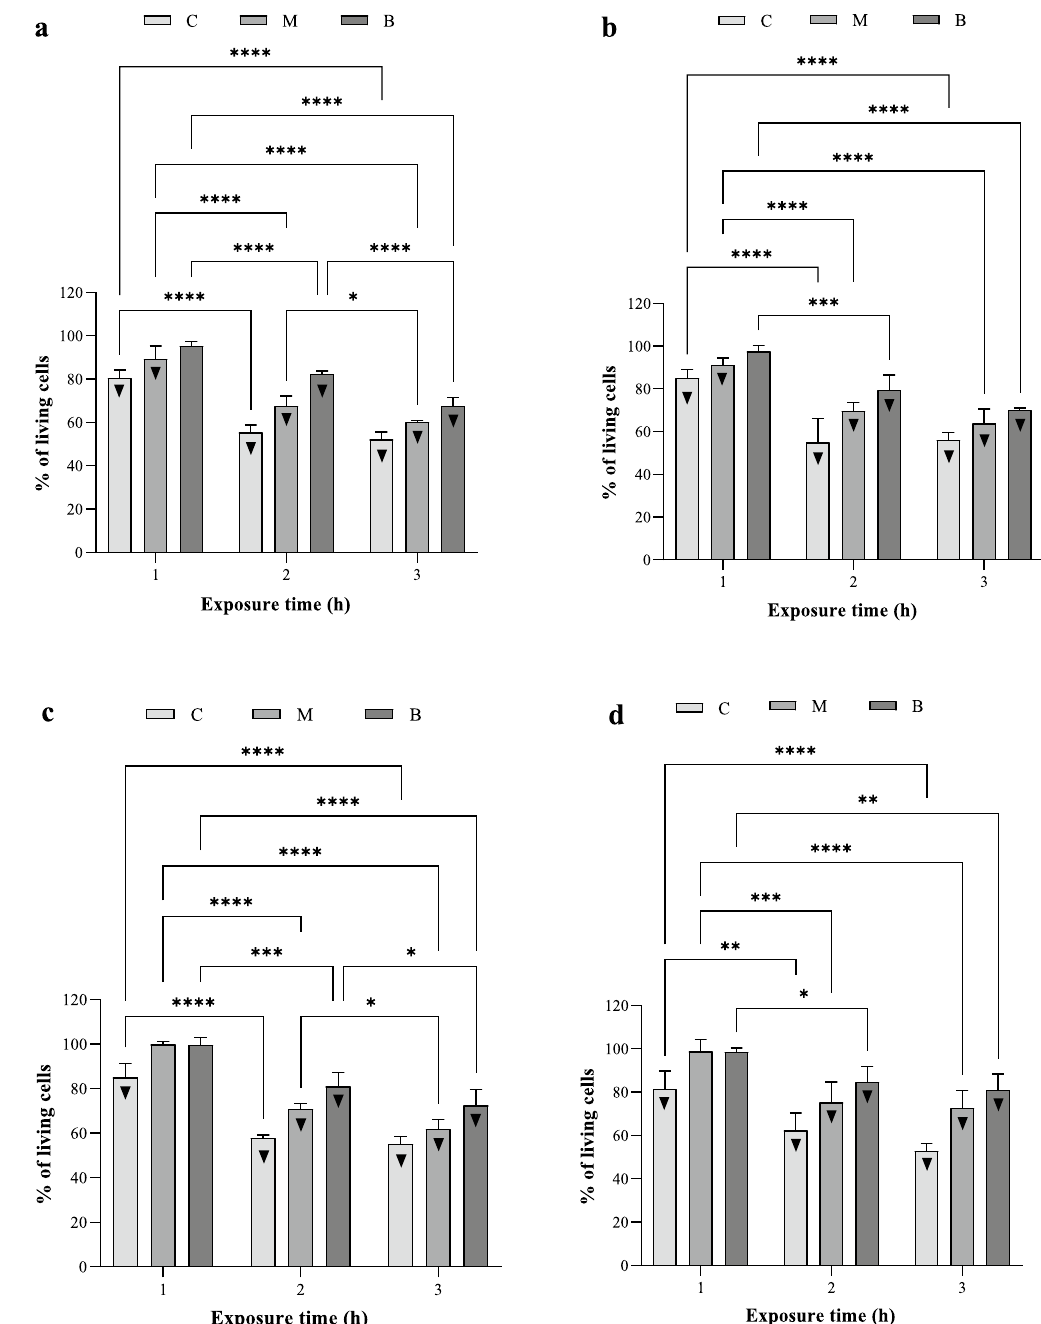
Figure 5. Percent of living biofilm-forming cells on successive agar discs treated with OCT-saturated carriers and exposed to RMF. ( a ) S. aureus —RMF of 5 Hz, ( b ) S. aureus —RMF of 50 Hz, ( c ) P. aeruginosa —RMF of 5 Hz and ( d ) P. aeruginosa —RMF of 50 Hz. The results are presented as % reduction of living biofilm-forming cells on successive agar discs treated with OCT-saturated carriers and exposed to RMF in comparison to the settings with the carriers soaked with OCT but unexposed to RMF and expressed as a mean ± SEM. The asterisks in the graphs indicate statistically significant differences between OCT-treated biofilms exposed to RMF for different time (* p < 0.05, ** p < 0.01, *** p < 0.001, **** p < 0.0001). ▼ —statistically significant differences ( p < 0.05) between OCT-treated/RMF-exposed and OCT-treated/RMF-unexposed